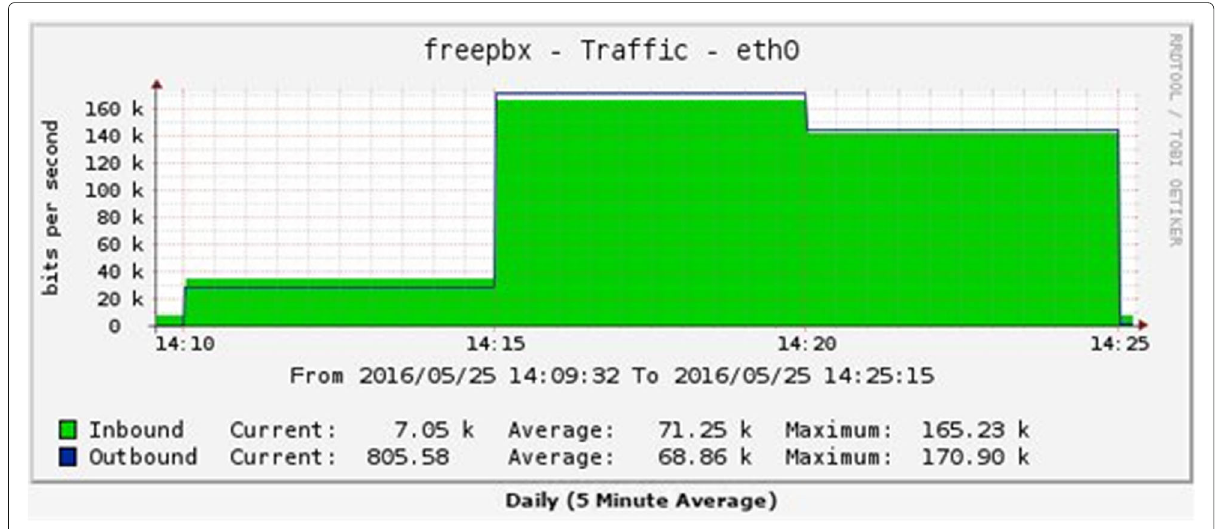
Fig. 13 Network traffic graph using Cacti